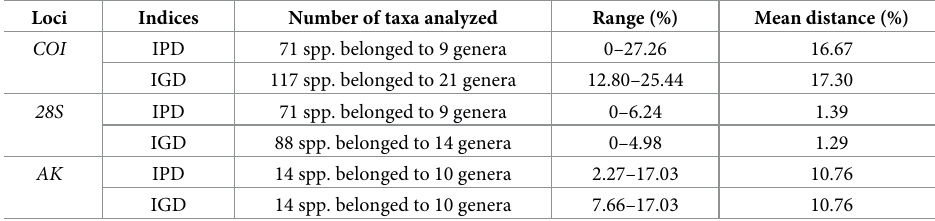
Table 6. Sequence divergences (K2P) at the three loci for scuttle flies at interspecific/intergeneric levels. Loci Indices Number of taxa analyzed Range